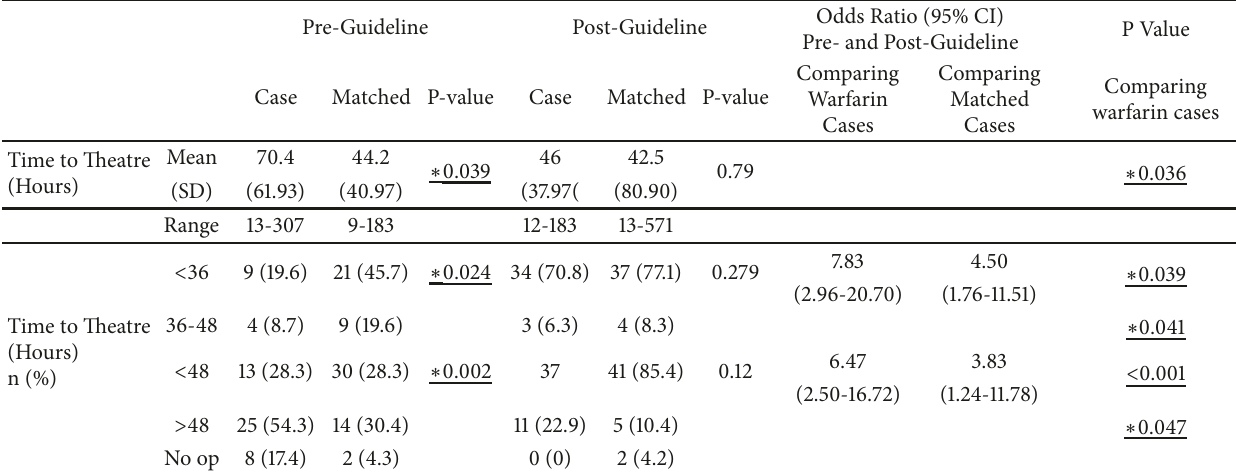
Table 3: A comparison of time to theatre between pre- and post-guideline, and warfarinised and matched patients. Pre-Guideline